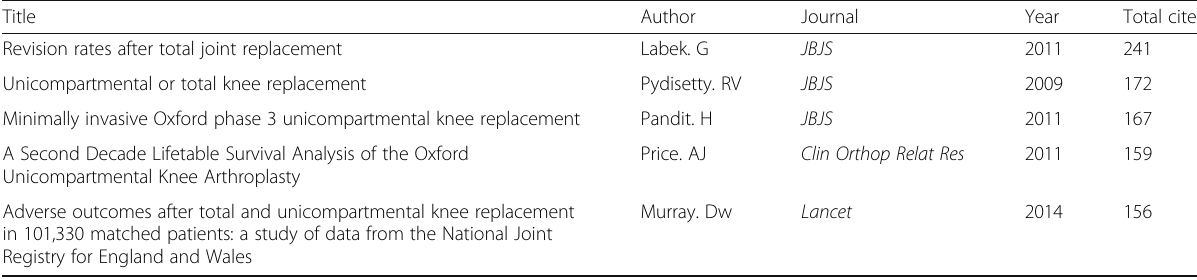
Table 1 Top 5 highly-cited papers on UKA from 2009 to 2019 in the WOS database